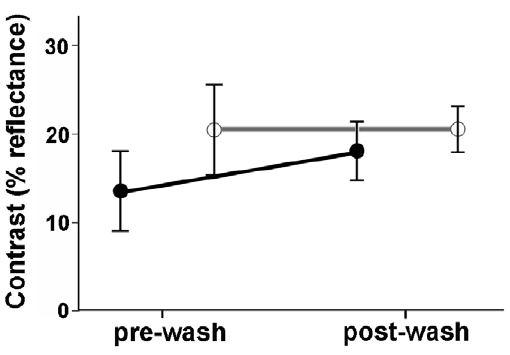
Figure 7. Effects of the ethanol wash on contrast in brightness between black and white feathers. Means 6 SE of contrast between black and white feathers of black-capped chickadees affected (filled symbols) and unaffected (open symbols) by the keratin disorder before and after the ethanol wash treatment.